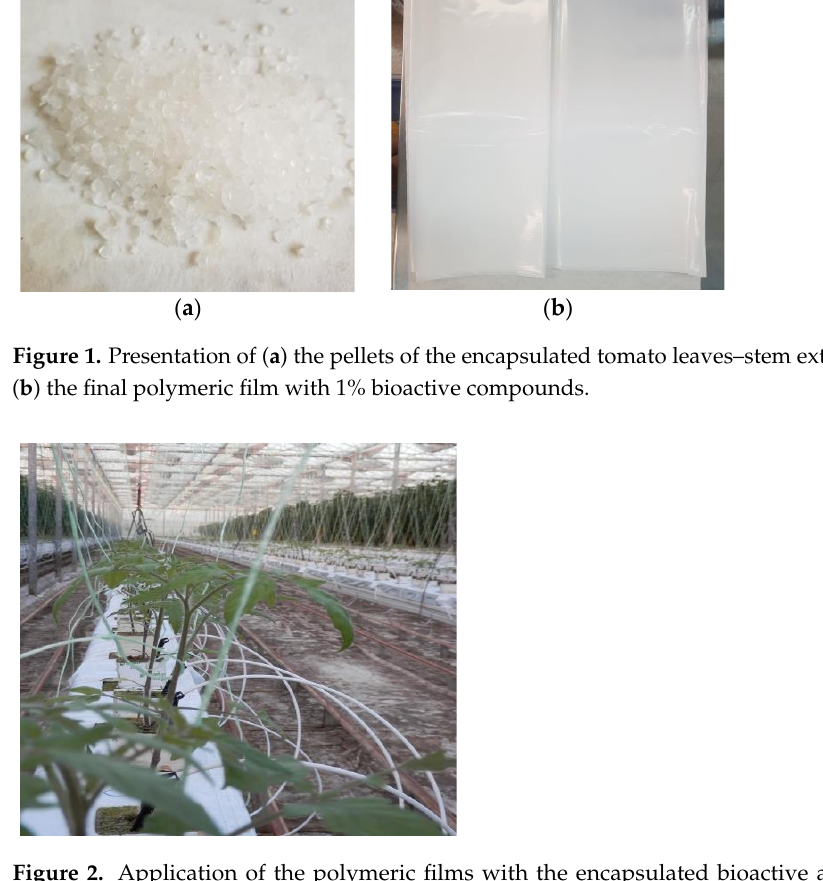
Figure 3. Total yield (kg/m 2 ) per experimental piece per month. Figure 4. Marketable yield (kg/m 2 ) per experimental piece per month.